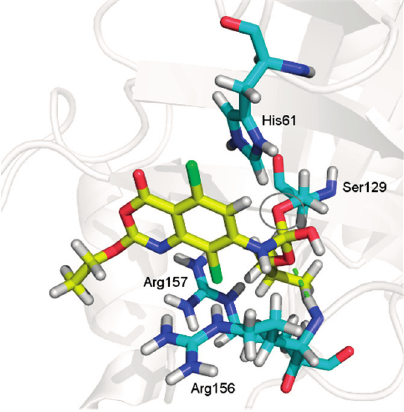
Figure 7. Covalent docking between benzoxazinone 15 and HSV-1 protease, showing the presence of a covalent bond between Ser129 and the R 2 substituent of the ligand.